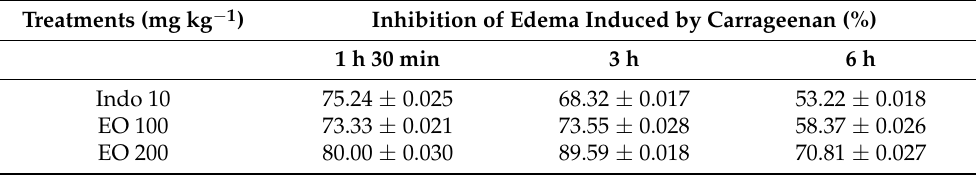
Table 2. Percentage decrease in volume of the left hind paw in rats treated with the essential oil of Thymus leptobotrys Murb.